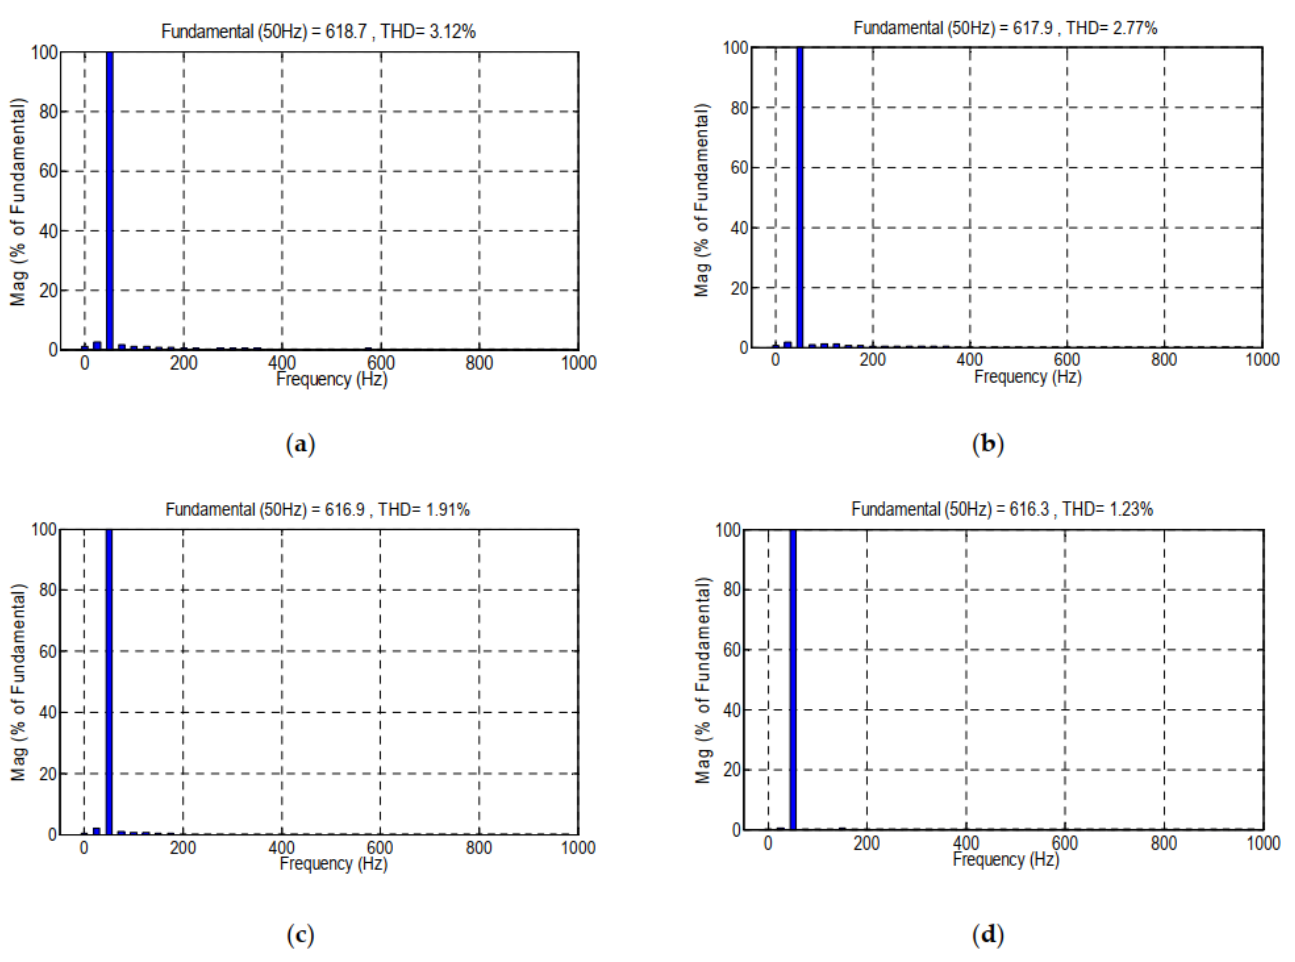
Figure 20. Spectrum analysis for the current injected ig-a by: SMC ( a ); DPC ( b );BSC ( c ); MPC ( d ).